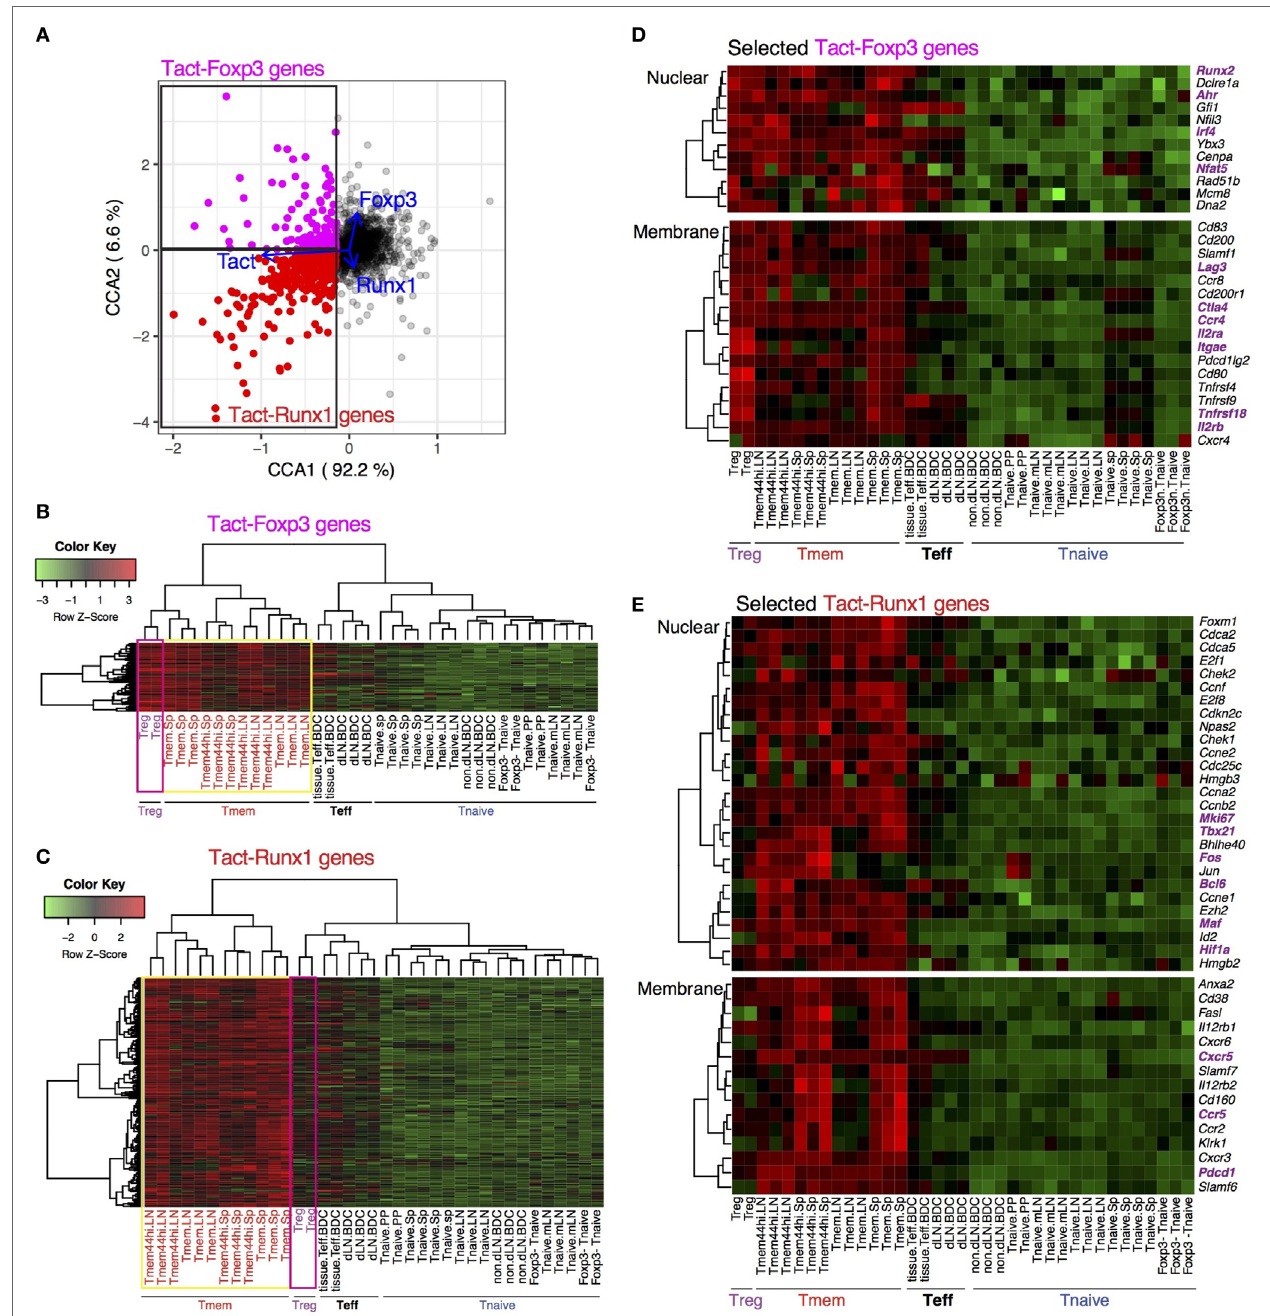
FigUre 4 | Differential regulations of transcriptional modules for activation in Treg and Tmem by Foxp3 and Runx1. (a) Definition of Tact-Foxp3 genes and Tact-Runx1 genes. In the gene plot of the canonical correspondence analysis (CCA) solution in Figure 3B , Axis 1-low genes (25th percentile low) were designated as activation genes , and further classified into Tact-Foxp3 genes and Tact-Runx1 genes by Axis 2, which have high correlations to Treg and Tmem samples, respectively, in the CCA cell space ( Figure 3a ). (B) Heatmap analysis of all the Tact-Foxp3 genes. (c) Heatmap analysis of all the Tact-Runx1